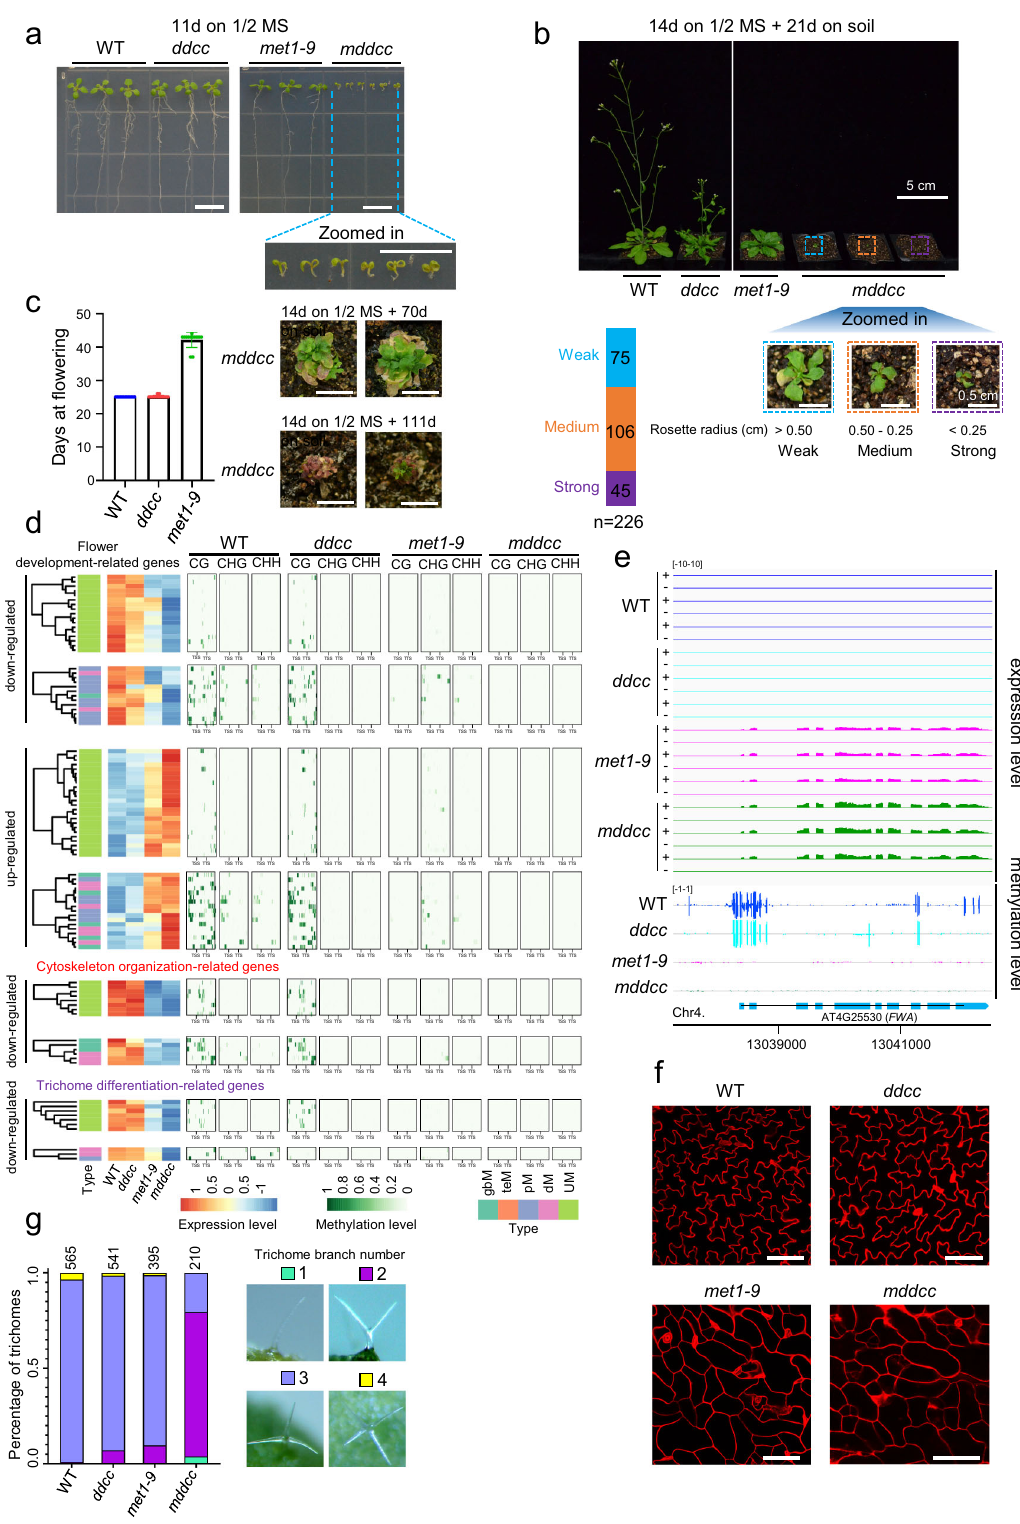
maintain DNA methylation in endosperm since their expression levels are up-regulated in endosperm relative to other tissues 68 . Of note, a function of these or other yet-to-be-identi fi ed DNA methyltransferases in very limited speci fi c cells or at certain developmental stages, of which the contribution might have been ruled out at this point.